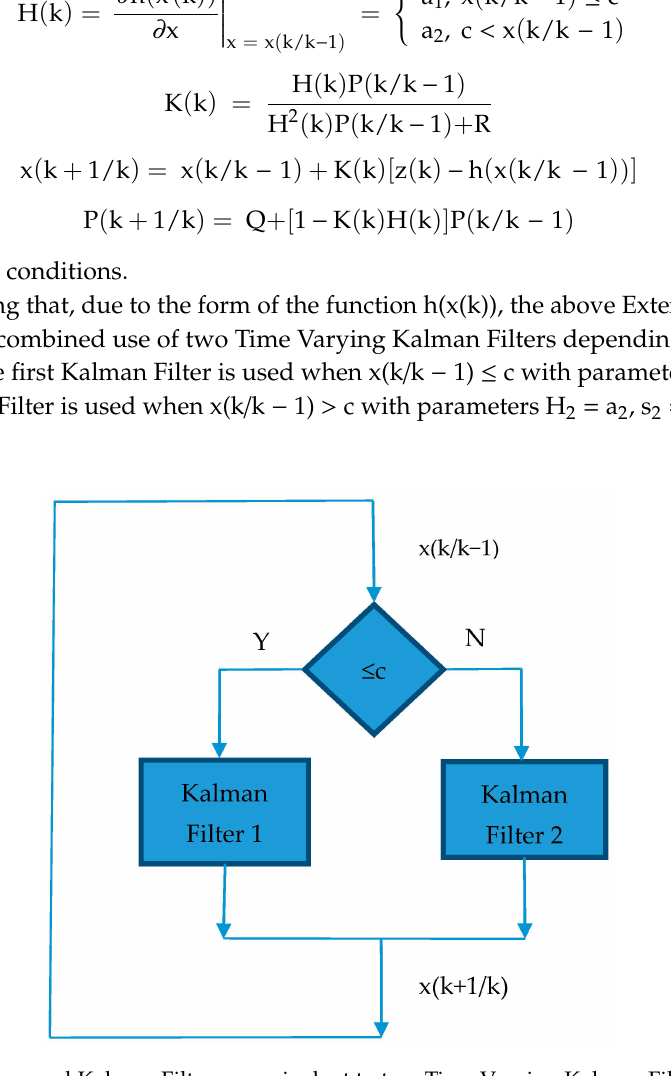
Figure 2. The proposed Kalman Filter as equivalent to two Time Varying Kalman Filters combined.